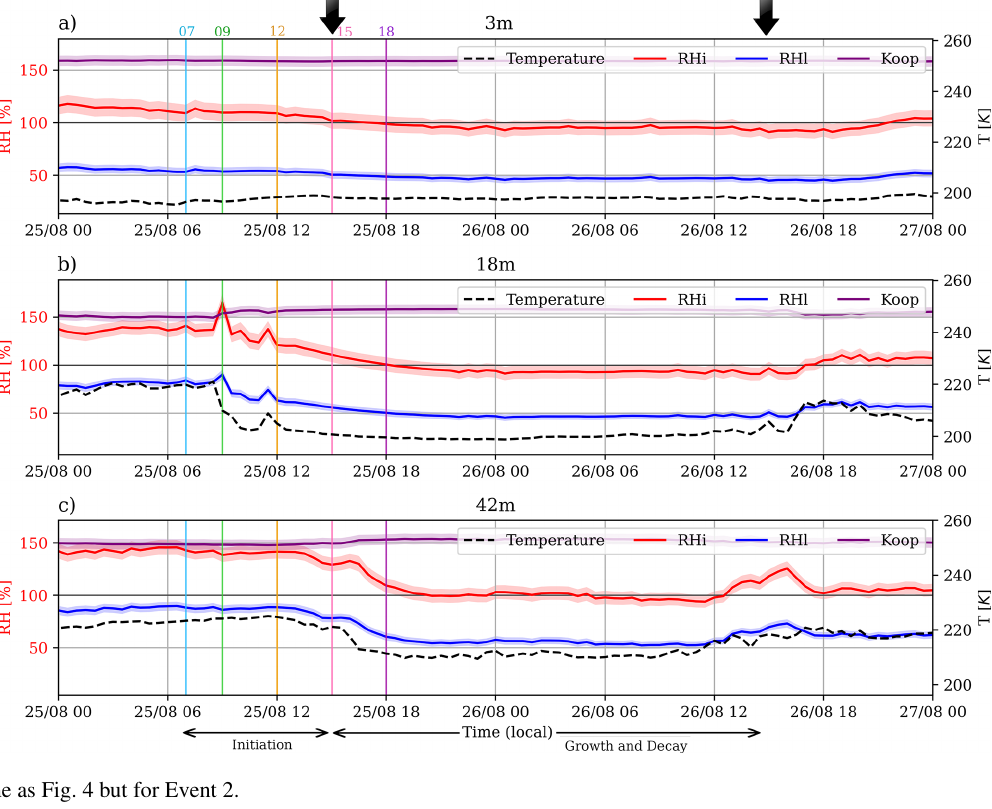
Figure 8. Same as Fig. 4 but for Event 2.